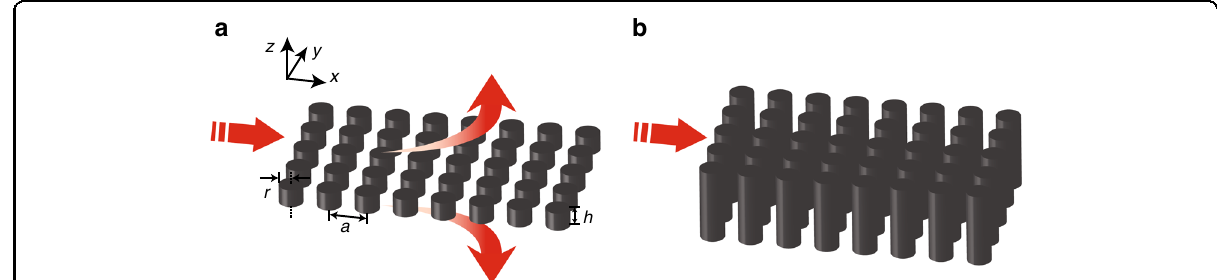
Fig. 1 Schematic diagram of an ultra-low-loss on-chip zero-index PhC slab based on a bound state in the continuum (BIC). a Zero-index PhC slab without BICs whose radius, pitch and height are r , a and h . A photonic dipole mode forming the zero index results in out-of-plane radiation, dramatically increasing the propagation loss of the material. b Zero-index PhC slab with a BIC. At a particular height, all the upward/downward out-of-plane radiation destructively